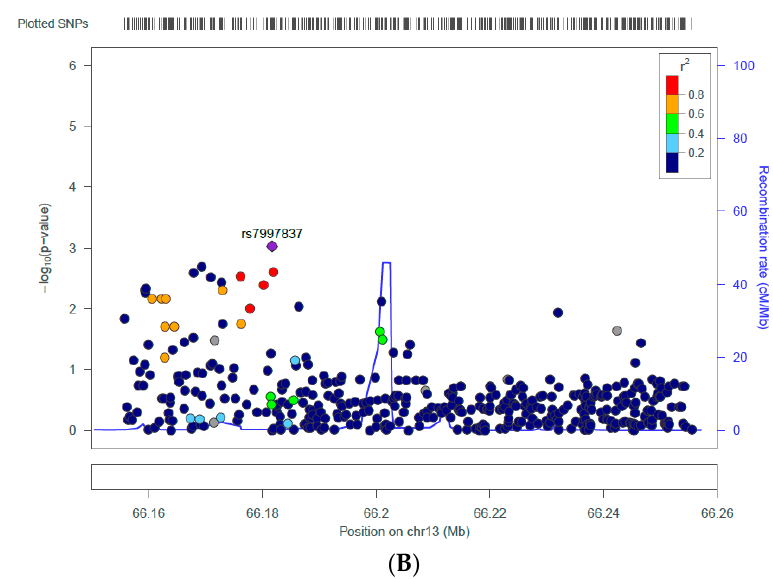
Figure 1 . Zoom plot of the interaction p values (SNP, single nucleotide polymorphism by childhood socioeconomic status on BMI) for all the SNPs within the gene/region containing index SNP rs9540493 in European American ( A ) and African American ( B ) samples in the Health and Retirement Study (HRS). SNPs are plotted by chromosomal position (GRCh 37, x axis) against the –log ( p -value) of their interaction with childhood socioeconomic status (parental education) on BMI (y axis). The most significant SNPs (rs9540488 in European Americans, rs7997837 in African Americans) are shown as purple diamonds. The SNPs surrounding the most significant SNPs are color-coded to reflect their linkage disequilibrium with this SNP as shown in the inset (taken from pairwise r 2 values from the 1000 Genomes Project November 2014 release, EUR panel in A and AFR panel in B).